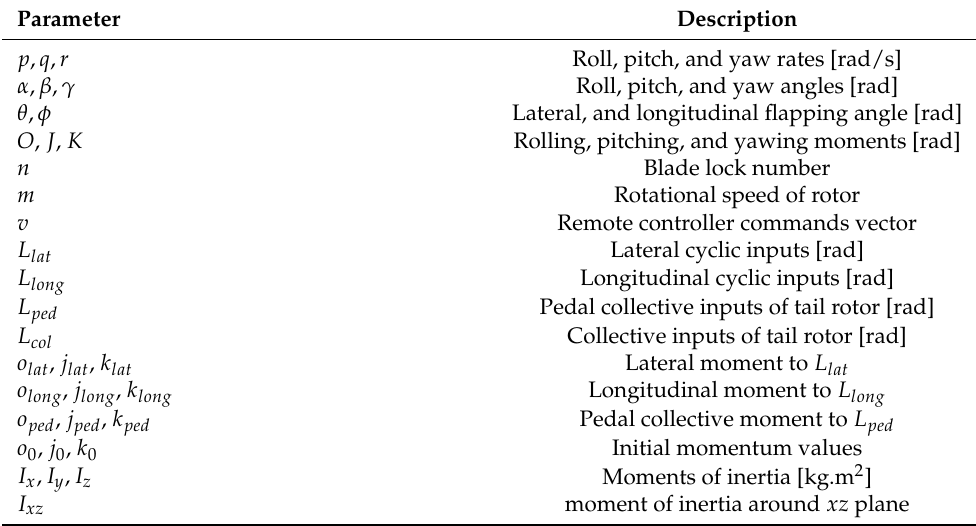
Figure 1. Description of roll, pitch, and yaw in the dynamic helicopter model. Table 1. The helicopter model parameters